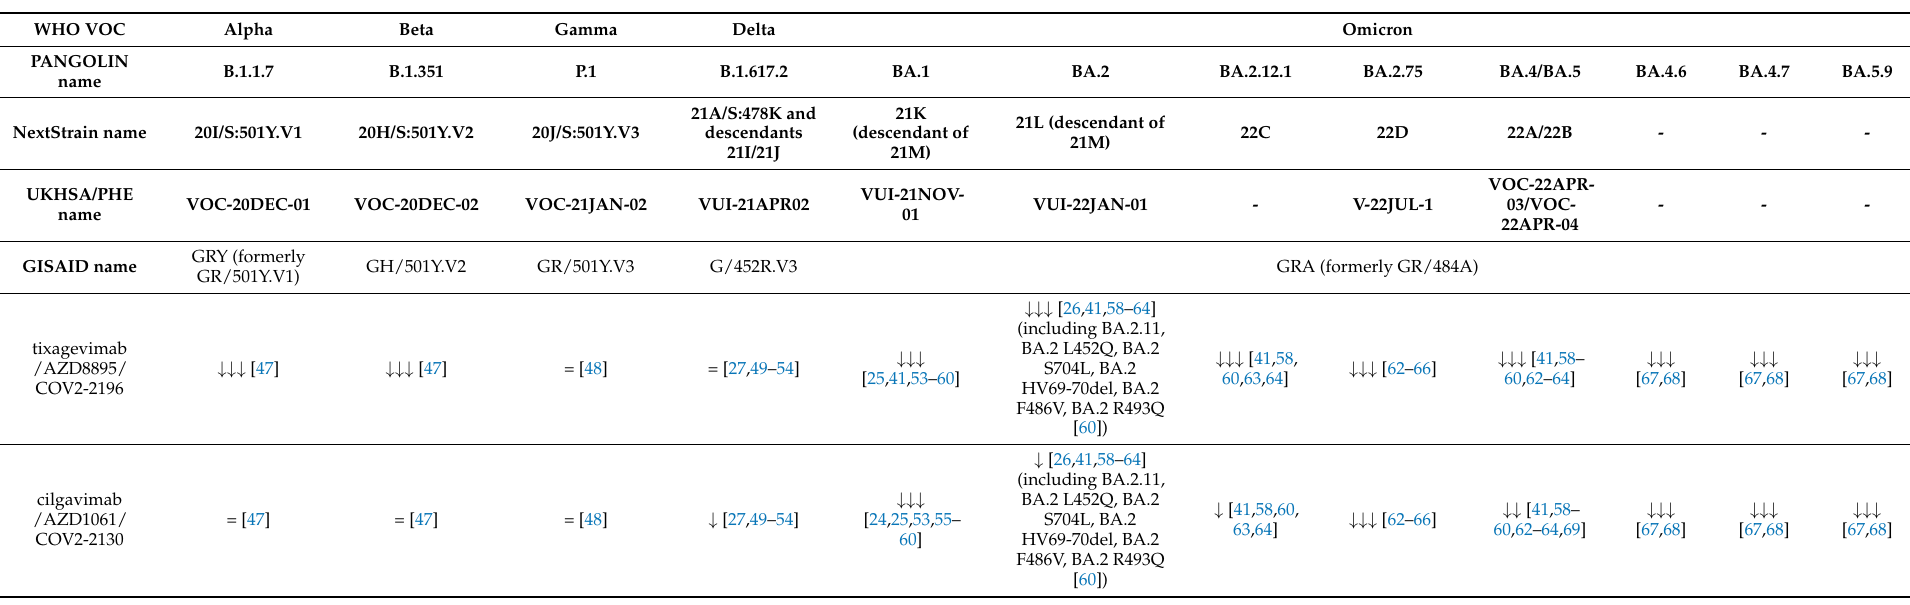
Table 2. In vitro efficacy of tixagevimab and cilgavimab against SARS-CoV-2 variants of concern (VOC). Arrows indicate fold-reductions in neutralizing activity compared to wild-type D614G strain (e.g., Wuhan-Hu-1, USA-WA1/2020, B.1, or other reference strains) (=no reduction; ↓ : 1–3 fold reduction; ↓↓ : 3–5 fold reduction; ↓↓↓ : >5 fold reduction). PHE: Public Health